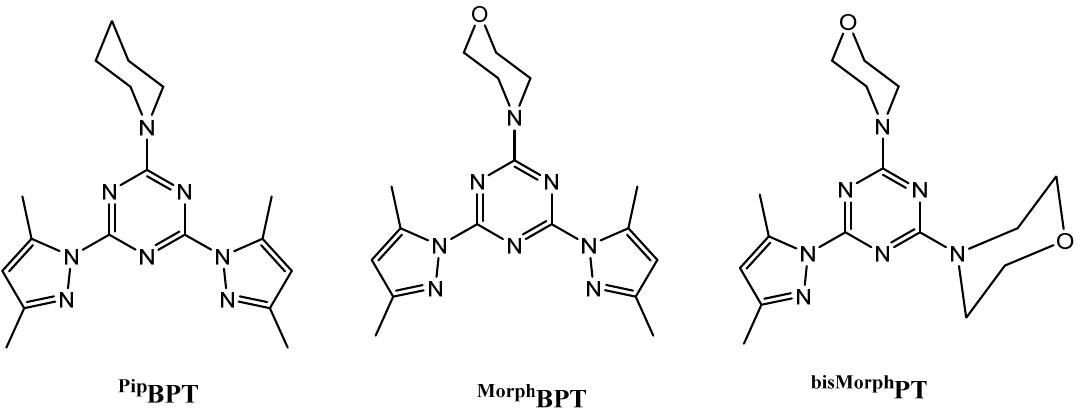
Figure 1. Structure of the mono - and bis-pyrazolyl- s -triazine ligands [21,22]. Ligands shown are: 2,4-bis(3,5-dimethyl-1 H -pyrazol-1-yl)-6-(piperidin-1-yl)-1,3,5-triazine ( Pip BPT ), 4-(4,6-bis(3,5-dimethyl- 1 H -pyrazol-1-yl)-1,3,5-triazin-2-yl)morpholine ( Morph BPT ), and 4,4’-(6-(3,5-dimethyl-1 H